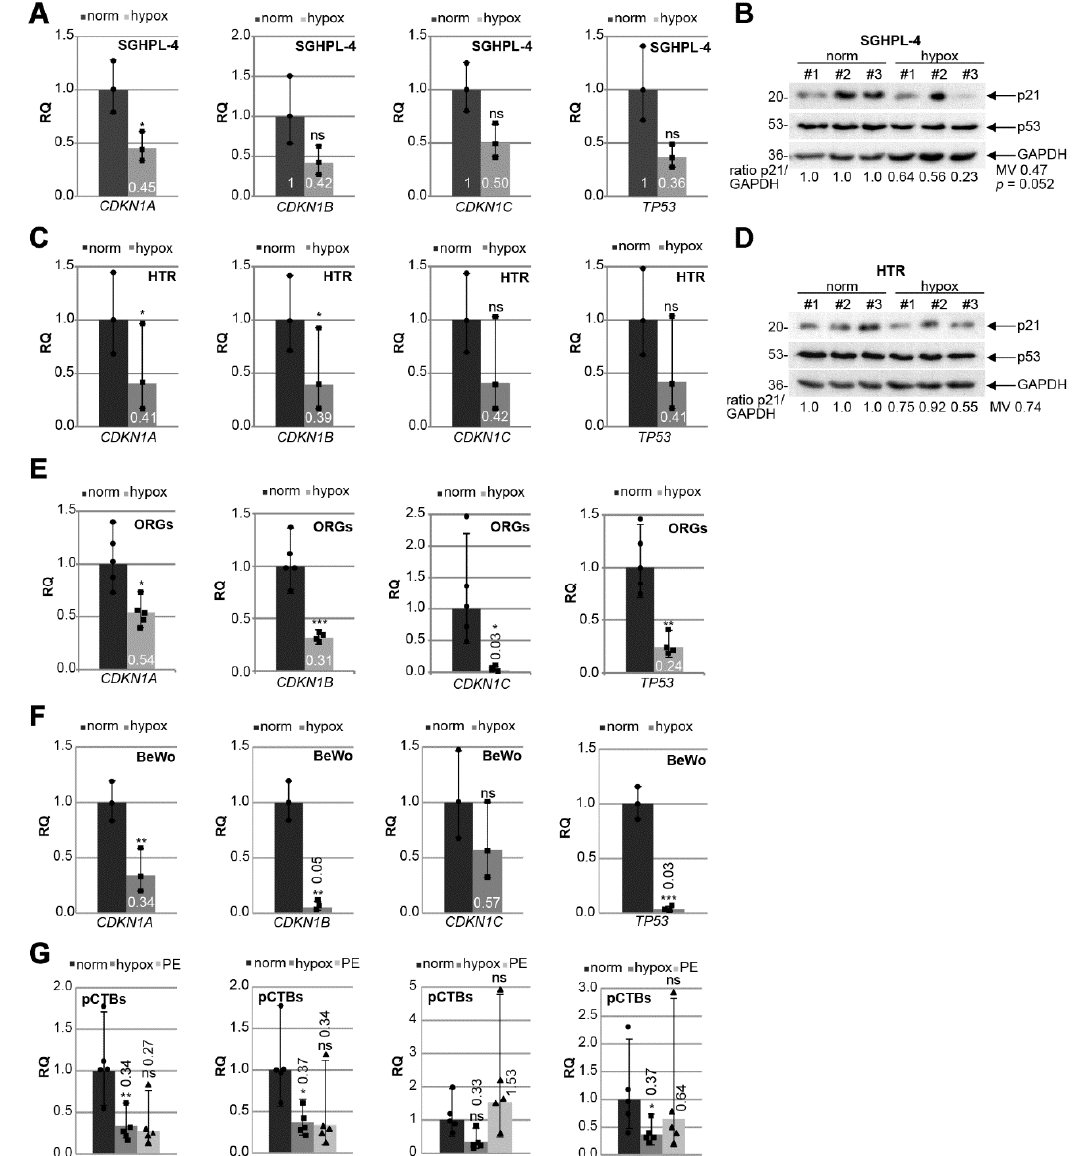
Figure 5. p21 expression is decreased in trophoblastic cell lines and in isolated primary trophoblasts under hypoxic conditions. Cells were grown under normoxia (norm, 21.4% O 2 ) or hypoxia (hypox, 1% O 2 ) for 48 h prior to RNA extraction or western blot analysis. ( A ) SGHPL-4 cells. Gene analysis of CDKN1A (p21), CDKN1B (p27), CDKN1C (p57) and TP53 (p53) is shown. The results ( n = 3) are presented as relative quantification (RQ) with minimum and maximum range. GAPDH was used as the endogenous control. ( B ) Western blot analysis with cellular lysates from SGHPL-4 cells ( n = 3). GAPDH served as the loading control. ( C ) HTR cells. Gene analysis of CDKN1A (p21), CDKN1B (p27), CDKN1C (p57), and TP53 (p53) is shown. The results ( n = 3) are presented as relative quantification (RQ) with minimum and maximum range. GAPDH was used as the endogenous control. ( D ) Western blot analysis with cellular lysates from HTR cells ( n = 3). GAPDH served as the loading control. ( E ) Organoids (ORGs) cultured under normoxia (norm; n = 5) or hypoxia (hypox; n = 4). Relative gene levels of CDKN1A (p21), CDKN1B (p27), CDKN1C (p57), and TP53 (p53) are shown. The results are presented as relative quantification (RQ) with minimum and maximum range. GAPDH was used as endogenous control. ( F ) BeWo cells. Relative gene levels of CDKN1A (p21), CDKN1B (p27), CDKN1C (p57), and TP53 (p53) are shown. The results ( n = 3) are presented as the relative quantification (RQ) with minimum and maximum range. GAPDH was used as the endogenous control. ( G ) Primary trophoblasts (pCTB) were isolated from healthy and preeclamptic (PE) donors. pCTBs from healthy donors were cultured under normoxia (norm; dot) or hypoxia (hypox, square), PE (triangle) pCTBs were grown under normoxia. The gene level of CDKN1A (p21), CDKN1B (p27), CDKN1C (p57), and TP53 (p53) was evaluated ( n = 5). GAPDH was used as the housekeeping gene control. Student’s t -test, * p < 0.05, ** p < 0.01, *** p < 0.001. ns, not significant; MV, mean